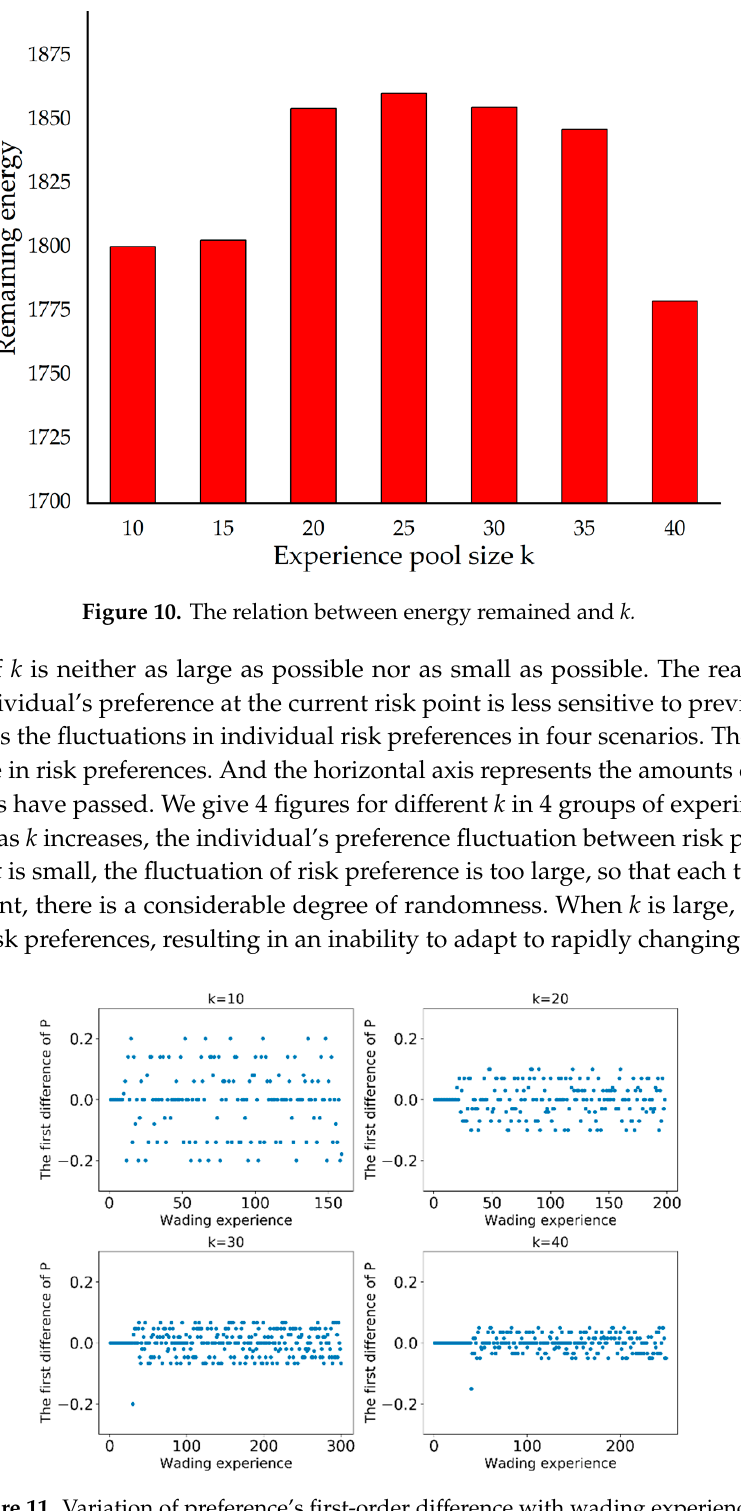
Figure 11. Variation of preference’s first-order difference with wading experience.